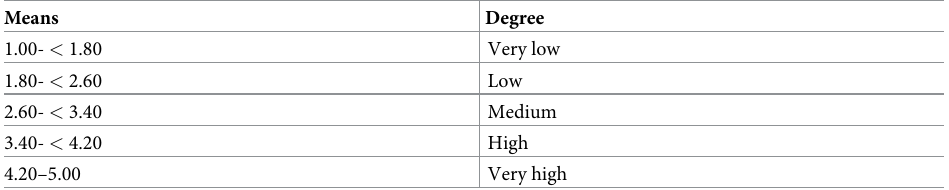
Table 3. The statistical standard for determining the assessment levels of the quality of training programs for teachers of students with disabilities in light of recent trends in the current